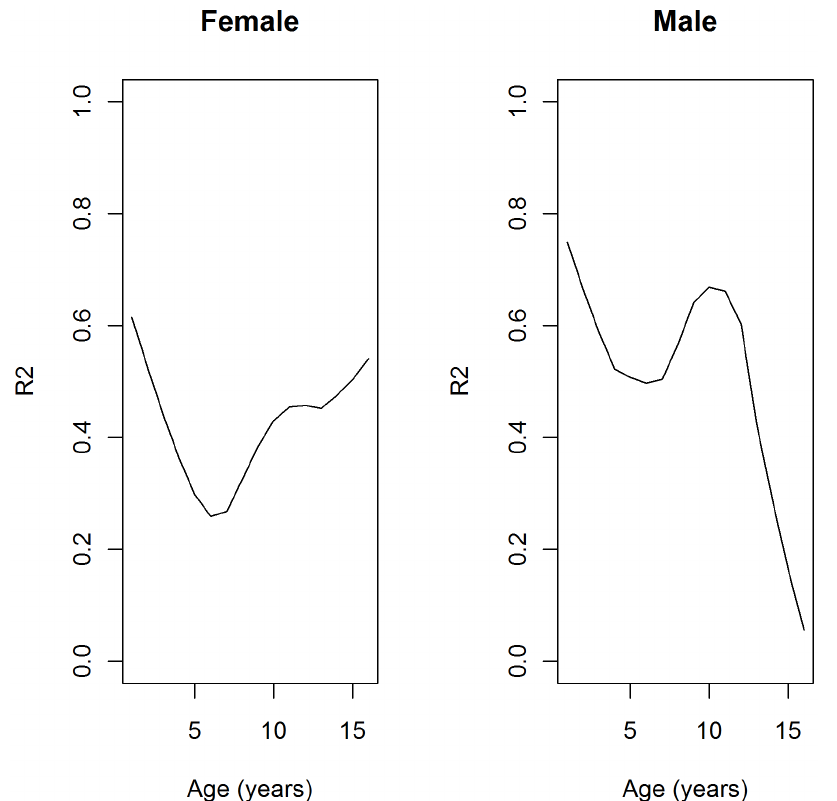
Figure 3. A smooth curve of the estimates from the longitudinal models of the proportion of BMI variation explained (R 2 ) at each time point in females and males from the ALSPAC cohort. R 2 derived from the longitudinal model at each year of follow-up between 1 and 16 years.